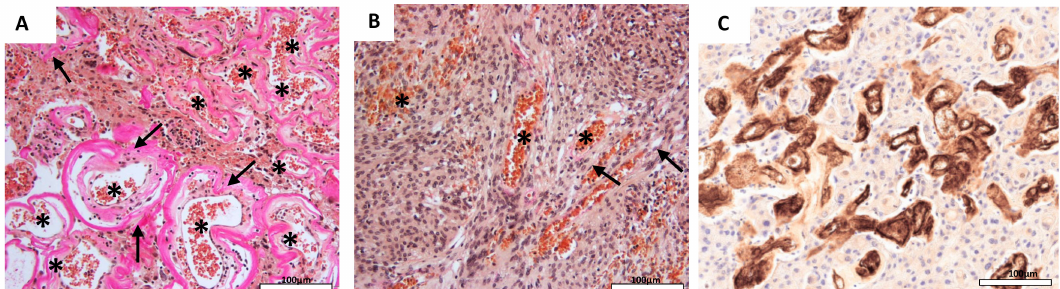
Figure 1. Vascular fibrosis and density in meningioma samples. Intratumoral blood vessels with thickened fibrotic vessel walls ( A , arrow) and increased vessel density ( A , asterisk) compared to inconspicuous blood vessels with narrow vessel walls ( B , asterisk) and flat endothelium ( B , arrow; Elastica–Van Gieson (EvG) staining, original magnification: 200 × ). Vessel density highlighted by anti-CD34 antibody ( C ; original magnification: 200 × ).